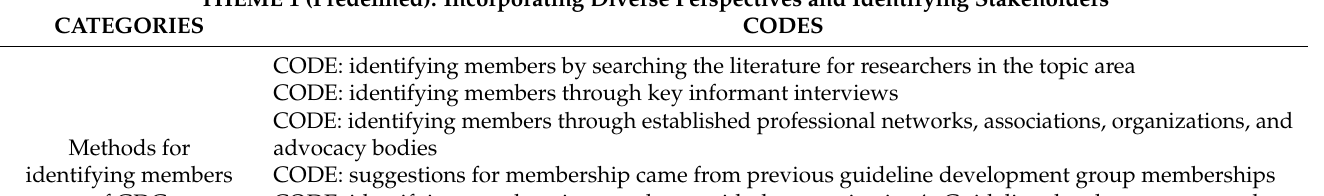
Table 2. Categoriesandcodesfortheme1: